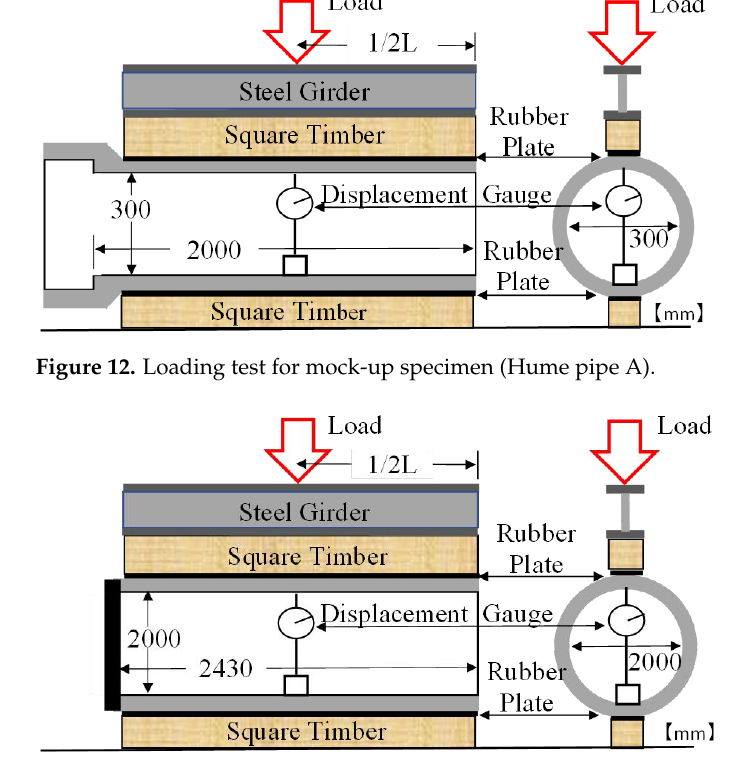
Figure 13. Loading test for mock-up specimen (Hume pipe B). Table 8. Centrifugal molding conditions.